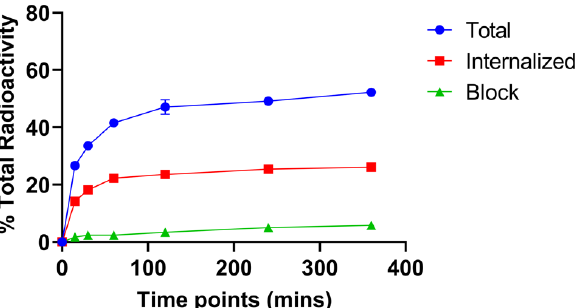
Figure 2. Representative binding and internalization curves of [ 67 Cu]Cu-SAR-BBN. Total bound and internalization levels were shown as a percentage of the total radioactivity added. Data are presented as triplicates of mean ± SD.